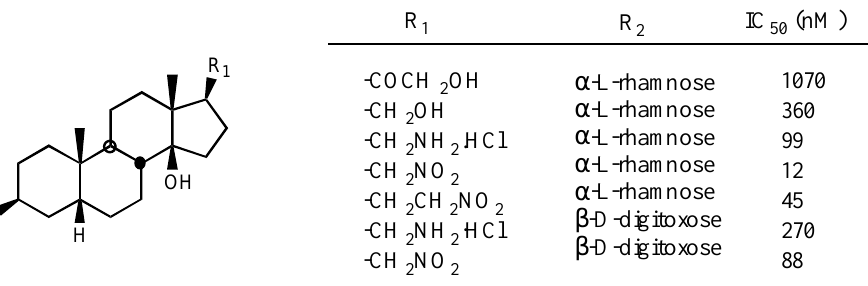
represents concentration 50